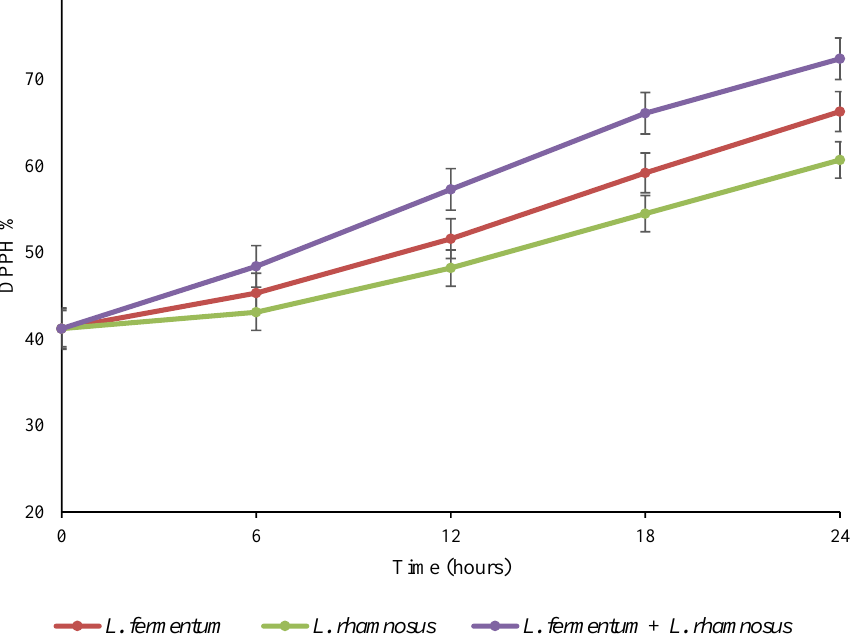
Figure 5. Changes in the antioxidant activity of quinoa seed fermented by pure and binary mixed cultures of two Lactobacillus species. The error bars reveal the standard deviation of DPPH in quinoa seed over 24 h of fermentation. L. rhamnosus : Lacticaseibacillus rhamnosus monoculture; L. fermentum : Limosilactobacillus fermentum monoculture; L. rhamnosus + L. fermentum : binary co-cultures of L. rhamnosus and L. fermentum.